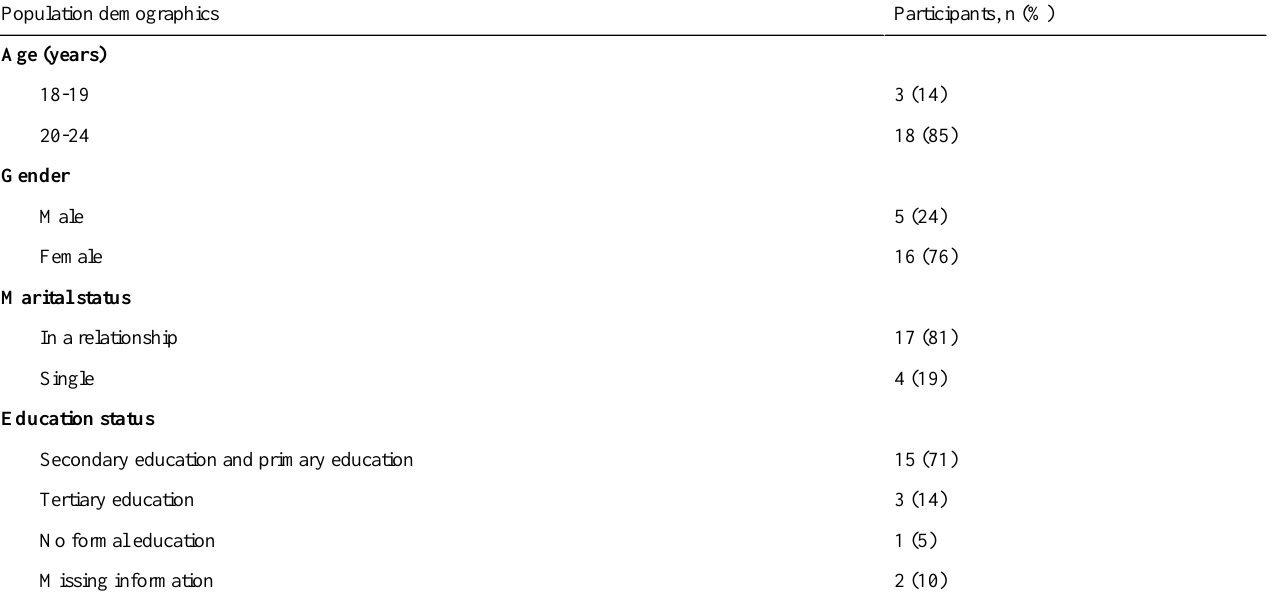
Table 1. Demographics of participants who took part in the qualitative study (N=21) a